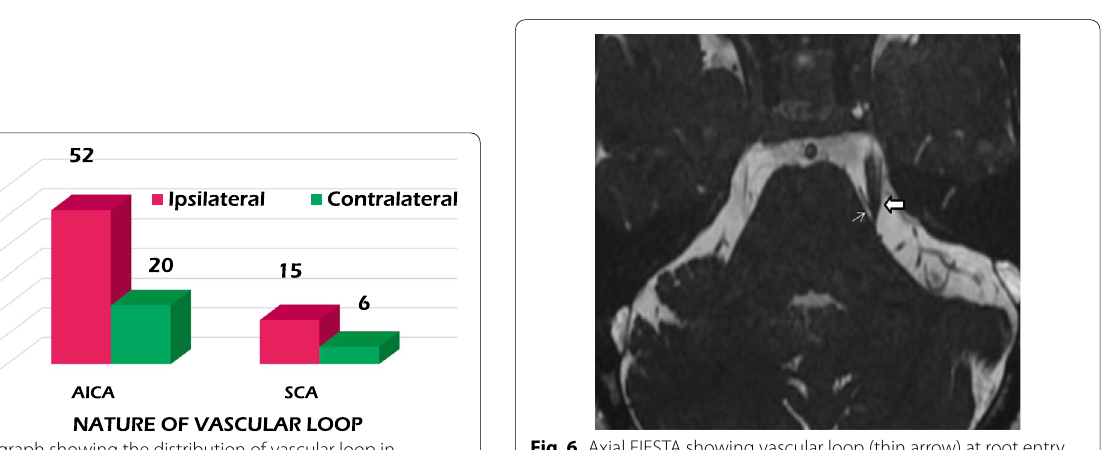
Fig. 5 Bar graph showing the distribution of vascular loop in ipsilateral (symptomatic) and contralateral (asymptomatic) nerves